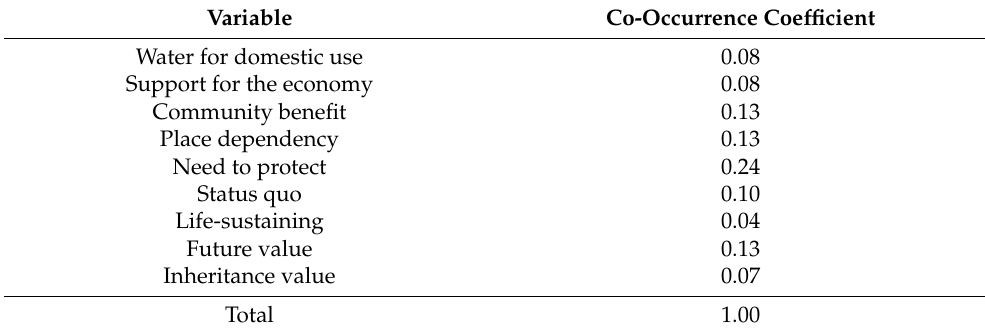
Table 3. Reasons why local residents are willing to pay for the conservation of Los Horcones River.